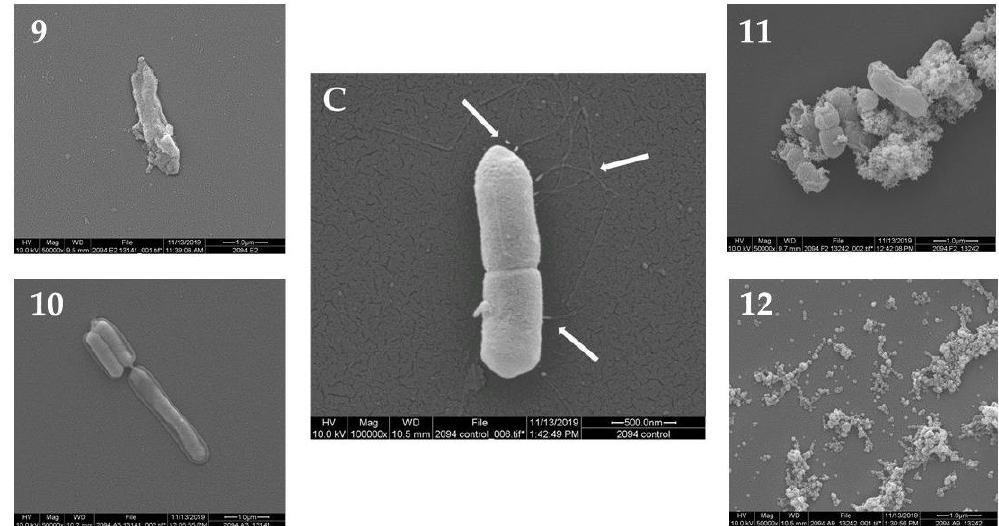
Figure 2. Morphology of L. monocytogenes F2365 cells treated with the plant extracts No. ( 5–8 ) (group B) observed using SEM, in comparison with L. monocytogenes F2365 that was not treated with samples—control ( C ). White arrows show flagella in ( C ).